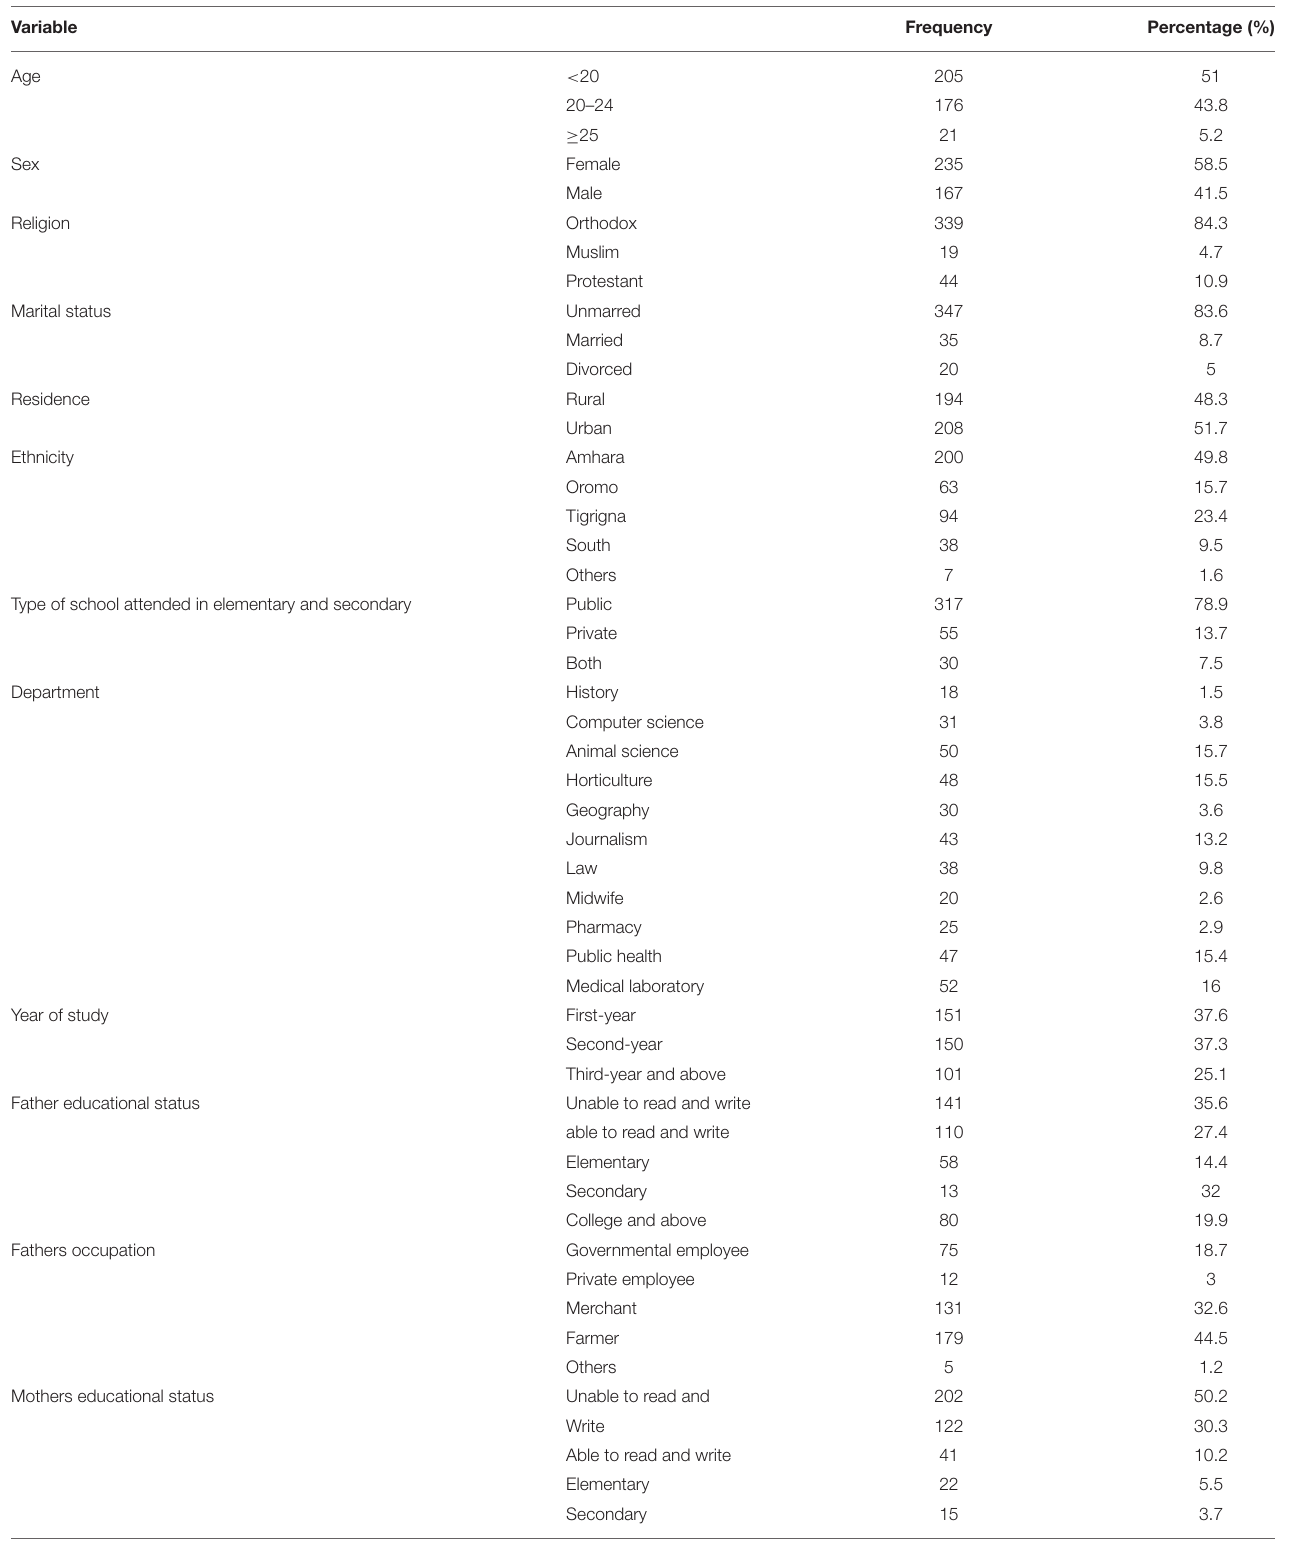
TABLE 1 | Socio-demographic, parent’s education and occupation, Sexual experience, and RH service utilization of participants in the study of knowledge on SRHR at Aksum University, northern Ethiopia, 2018/2019.